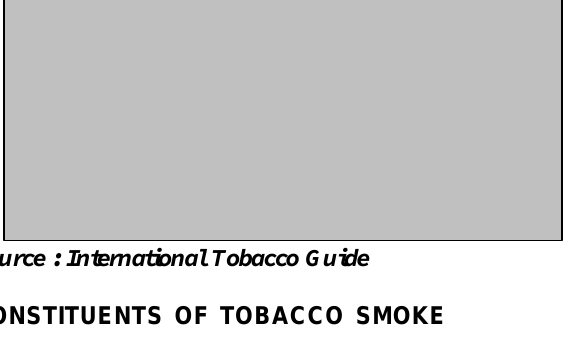
Table I : Annual Cigaratte Consumption in Nepal